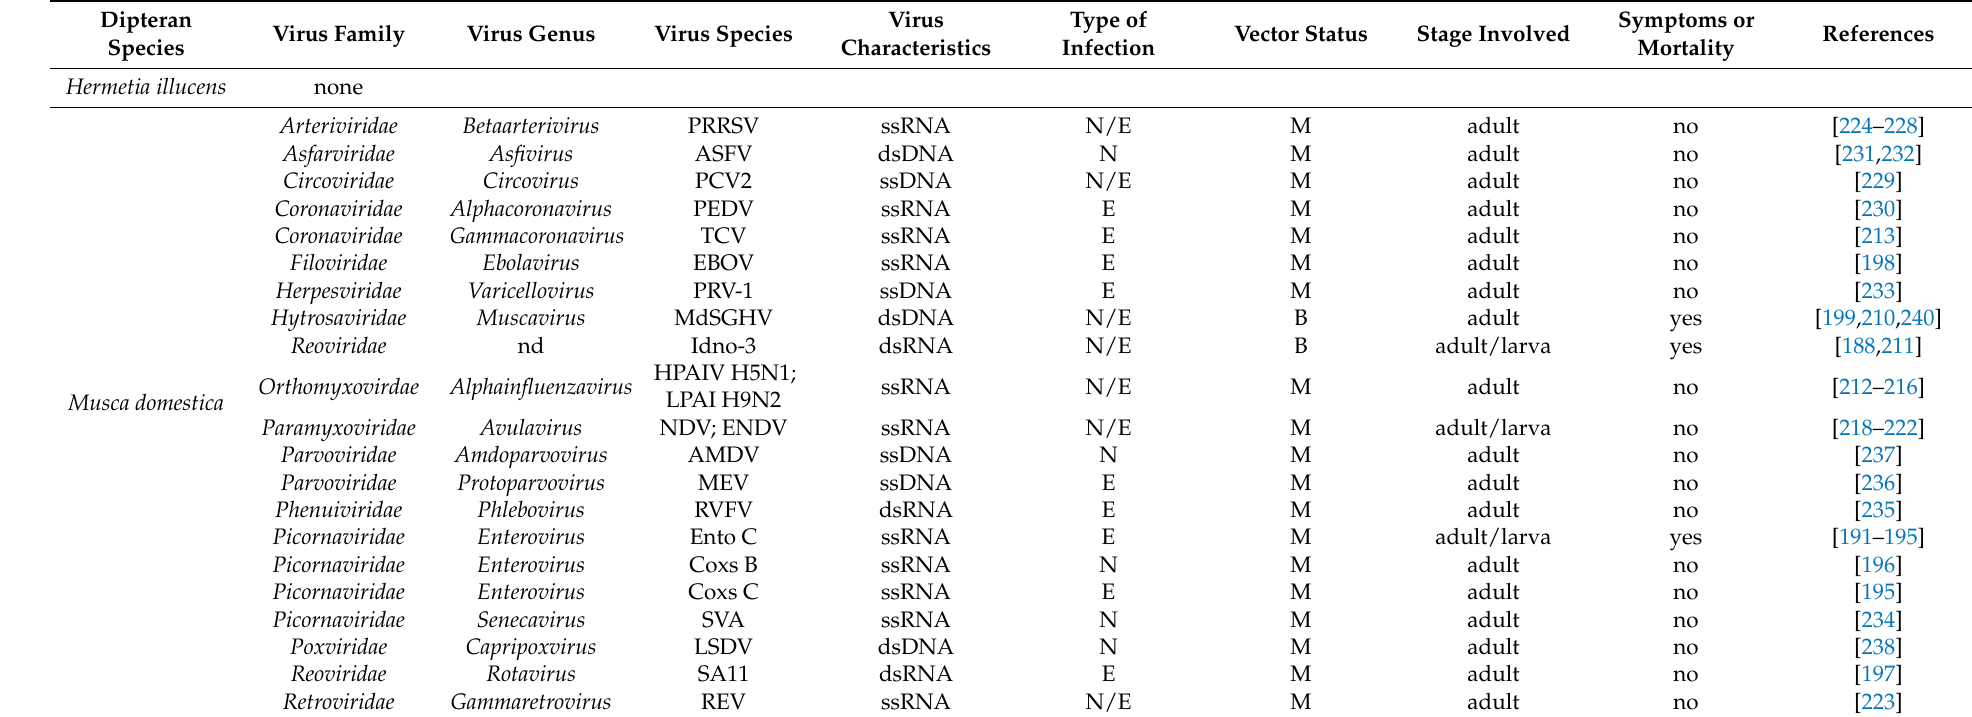
Legend: porcine reproductive and respiratory syndrome virus (PRRSV); African swine fever virus (ASFV); porcine circovirus 2b (PCV2); porcine epidemic diarrhea virus (PEDV); turkey coronavirus (TCV); Ebola virus (EBOV); Aujeszky’s virus (PRV-1); Musca domestica salivary gland hypertrophy virus (MdSGHV); idnoreovirus 3 (Idno-3); avian influenza virus (HPAIV H5N1; LPAI H9N2); Newcastle disease virus (NDV) and exotic Newcastle disease virus (ENDV); Aleutian mink disease virus (AMDV), Mink enteritis virus (MEV); Rift Valley fever virus (RVFV); poliomyelitis virus (Enterovirus C, Ento C); coxsackievirus B (Coxs B); coxsackievirus C (Coxs C); senecavirus A (SVA); lumpy skin disease virus (LSDV); Simian rotavirus 11 (SA11); reticuloendotheliosis virus (REV); single strain DNA (ssDNA); double strain DNA (dsDNA); single strain RNA (ssRNA); double strain RNA (dsRNA); natural infection (N); experimental infection (E); mechanical vector (M); biological vector